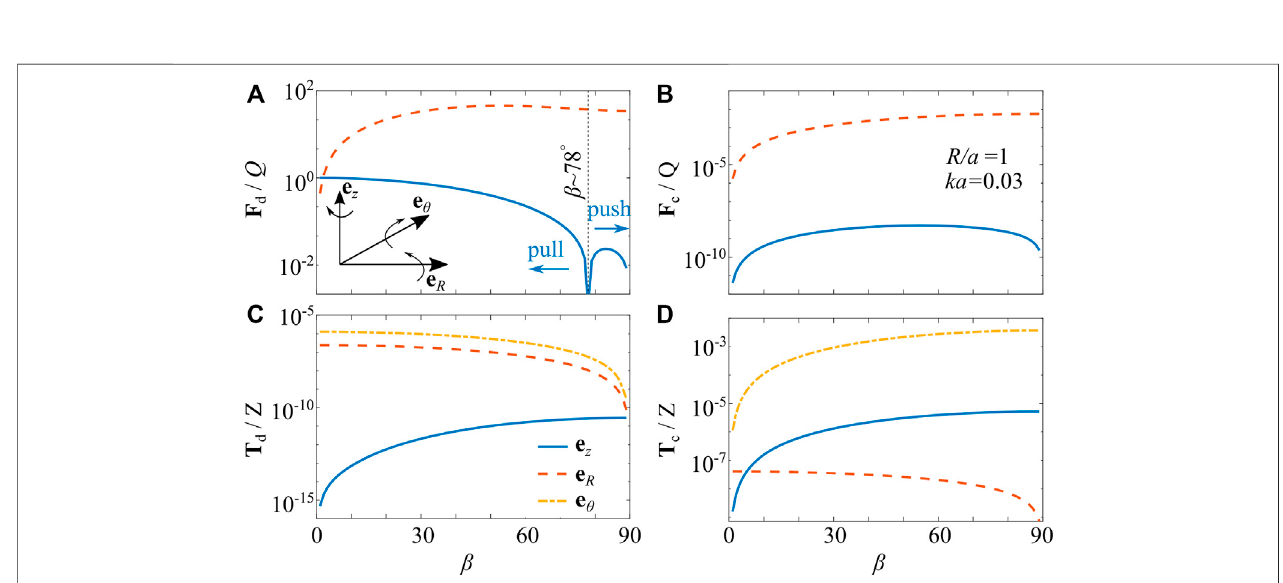
FIGURE3| Partialforces,panels (A),(B) ,andtorques,panels (C),(D) ,duetodirectandWilliscouplingacousticpolarizationinthevicinityofthebeamaxisat R / a =1 with a being the nominal radius of the asymmetric object given by its polarizability coef fi cients in Eq. 31 . The results are shown for the entire range of 0 < β < 90 ° to demonstrate theeffects ofwavefront deviatingfurther fromaplane ( β =0) onanasymmetric object ofsmallsize ka ≈ 0.03. Thecomponentsofthe forces and torques in the cylindrical coordinate system ( e R , e θ , e z ) are shown by different line types. For the forces in panel (A),(B) , the θ -component is zero. The magnitude of these forces are shown in the logarithmic scale to indicate the difference of orders of